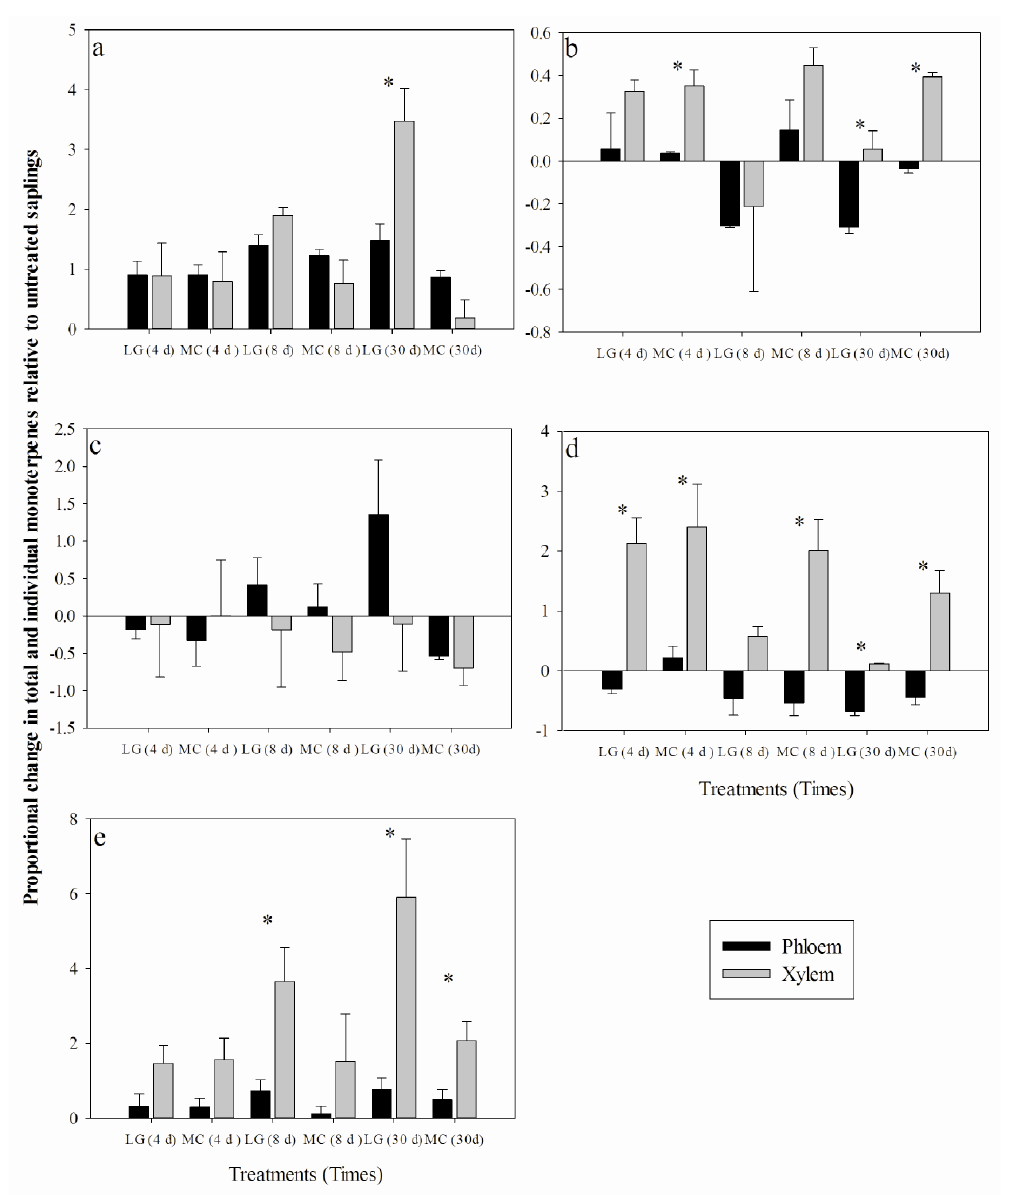
Figure 4. The change in total and individual monoterpenes between the phloem and xylem of the stem in treated saplings relative to the corresponding total and individual monoterpenes in untreated saplings at all time points after treatment. LG = L. qinlingensis -inoculated saplings; MC = Mechanically wounded saplings; a = total monoterpene concentrations; b = α - pinene; c = β - pinene; d = bornyl acetate; e = limonene + β - phellandrene; * indicates that there was a significant difference ( p < 0.05) between the phloem and xylem of the stem in the same treated saplings based on a Student t -test at the time points; Each bar represents the mean total ± standard error of three